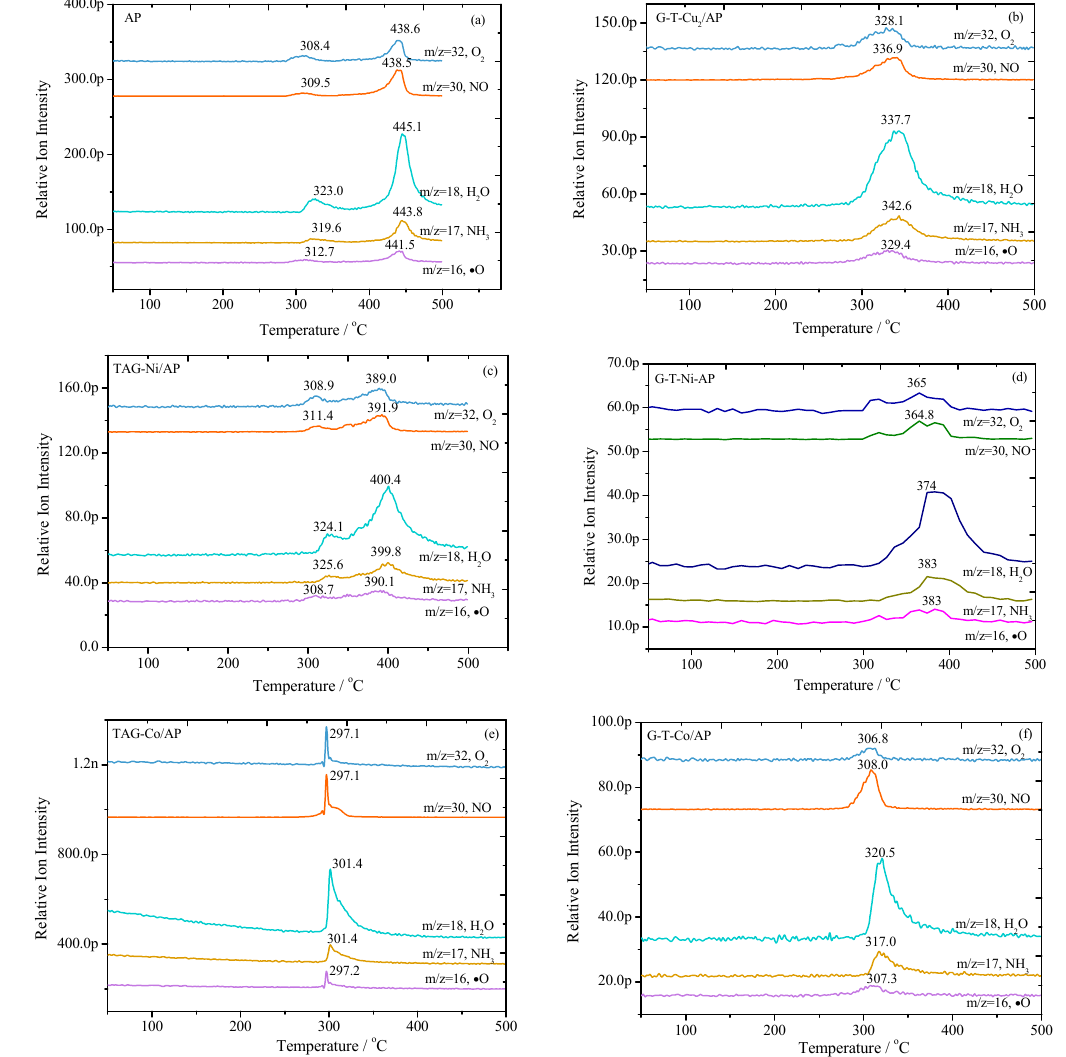
Figure 1. Temperature dependency of the ion flows from non-isothermal decomposition for pure AP and coated AP under a heating rate of 10 °C min − 1 using thermogravimetry coupled with mass spectrometry (TG/MS) technique: ( a ) pristine AP; ( b ) G-T-Cu 2 /AP; ( c ) TAG-Ni/AP; ( d ) G-T-Ni/AP; ( e ) TAG-Co/AP; ( f ) G-T-Co/AP; TAG—triaminoguanidine.